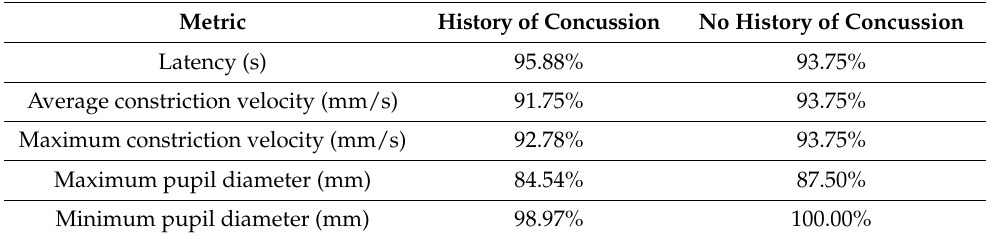
Table A4. Percentage of male and female cases (total concussed, N = 177). No significant differences were found between sexes for each PLR